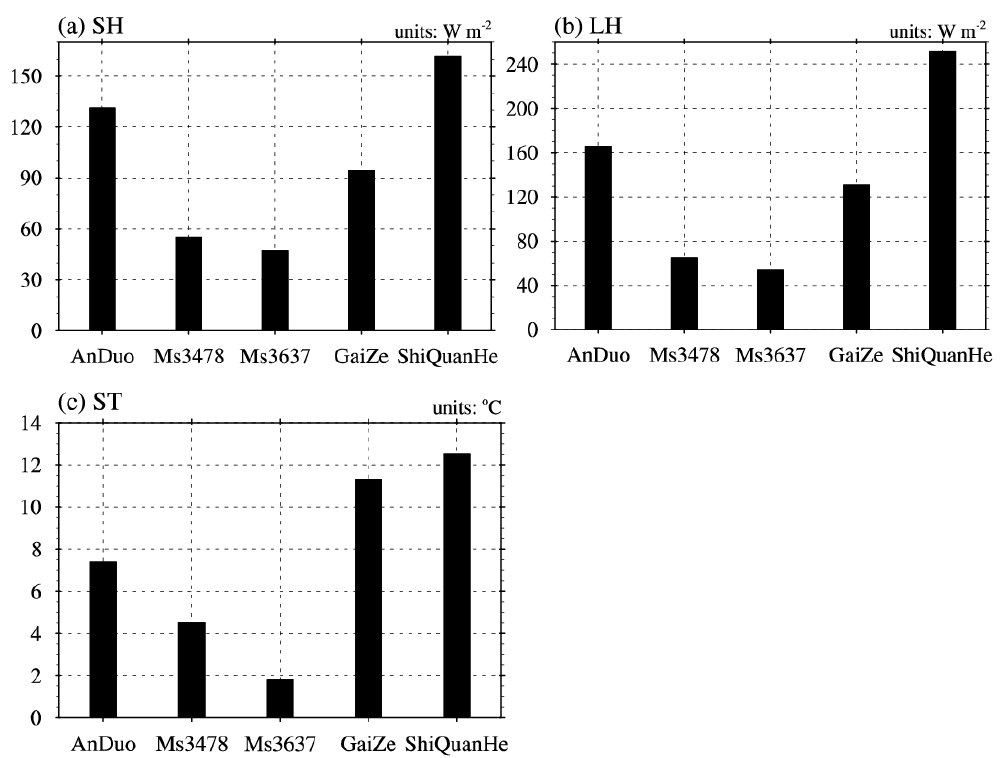
Figure 4. The maximal uncertainties in the simulated SH ( a ), LH ( b ) and ST ( c ) due to parameter uncertainties at different Tibetan sites during different study periods.